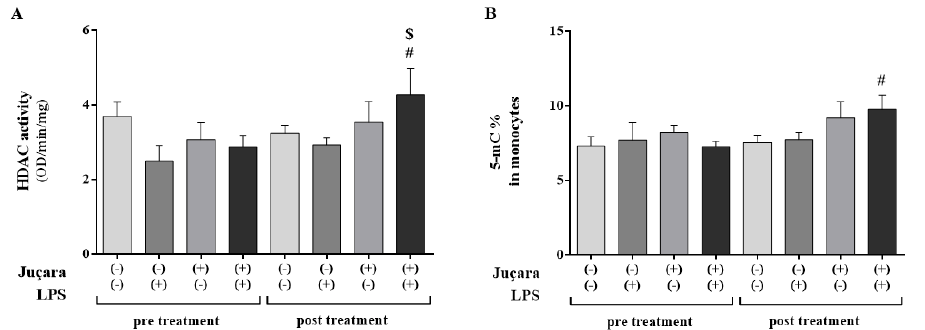
Figure 3. ( A ) Total HDAC activity and ( B ) methylated DNA levels in monocytes. # baseline versus post-treatment; $ placebo versus juçara group. ( n = 10 per group).